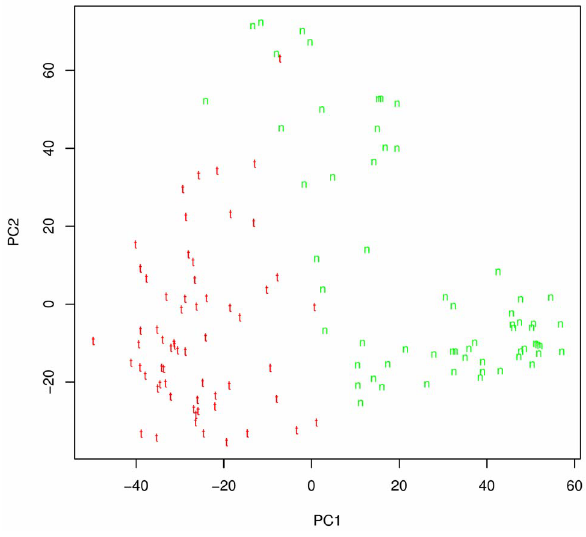
Figure 2. PCA analysis of GCA patients (124 chips from 62 patients). Red ‘‘t ‘‘ represents tumor and green ‘‘n’’ represents matched normal tissue.